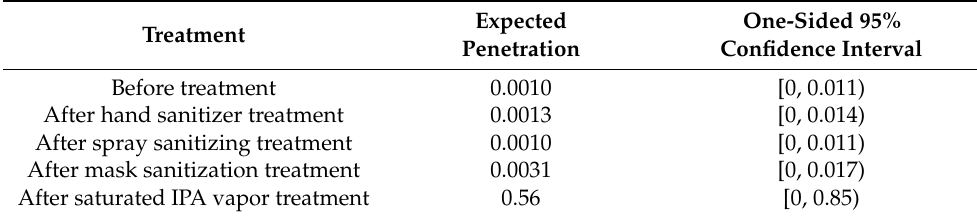
Table 7. Means and one-sided 95% confidence intervals for penetration of a randomly selected mask under the combined model. Expected One-Sided 95% Treatment Penetration Confidence Interval Before treatment 0.0010 [0, 0.011) After hand sanitizer treatment